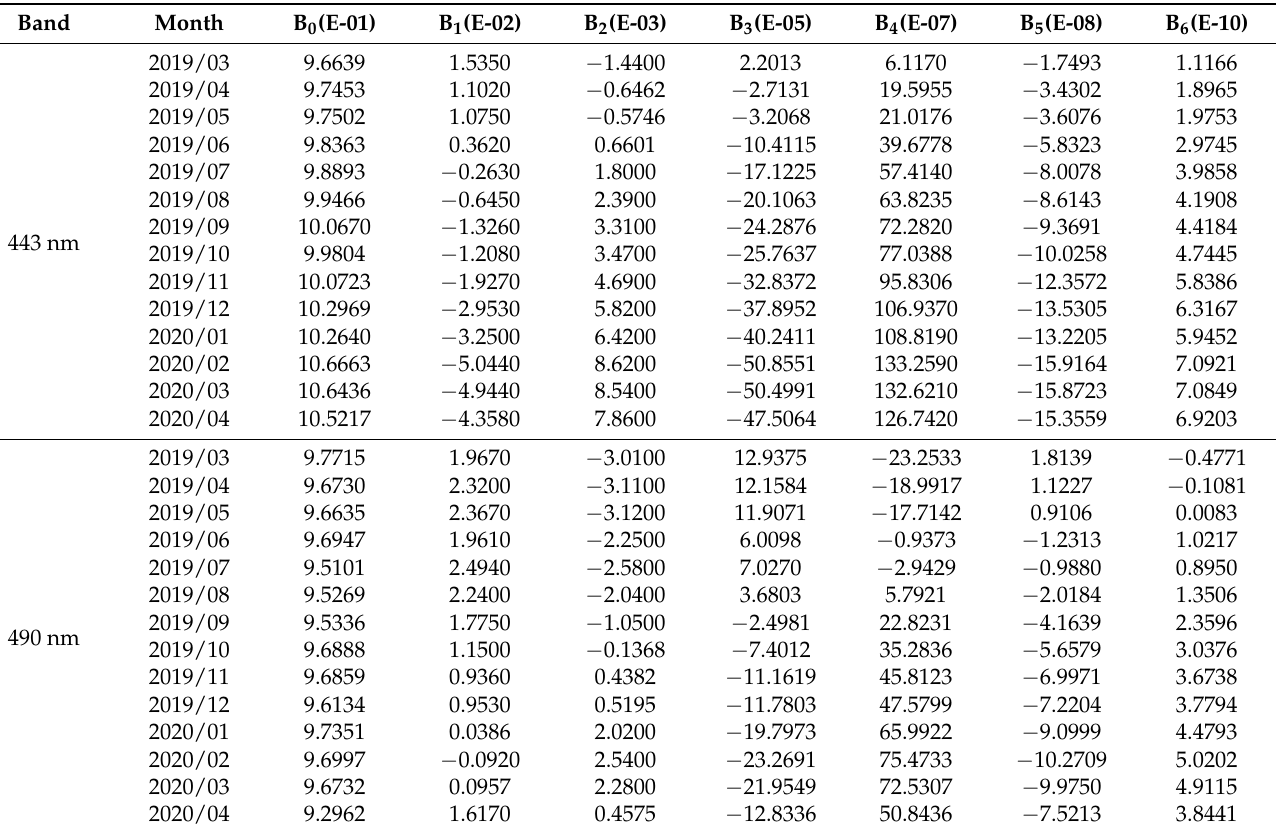
Table A1. The relative calibration coefficients of the polynomial fitting model function (8) at four visible bands of